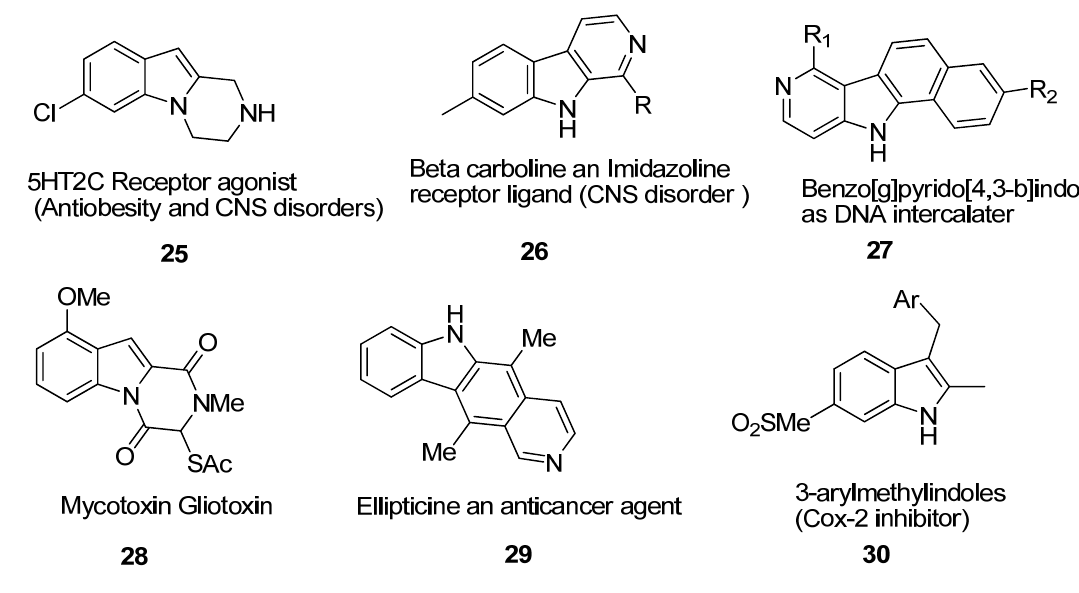
Figure 7. Pharmacologically active indole